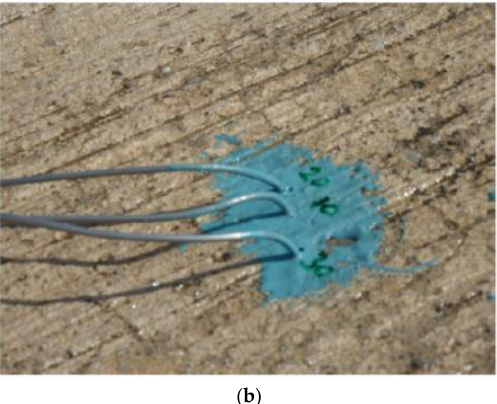
Figure 8. The layout of the test rig with Embedded and Pool thermocouples (marked with cyan square and black dots, respectively) ( a ) and embedded thermocouples ( b ) [57].